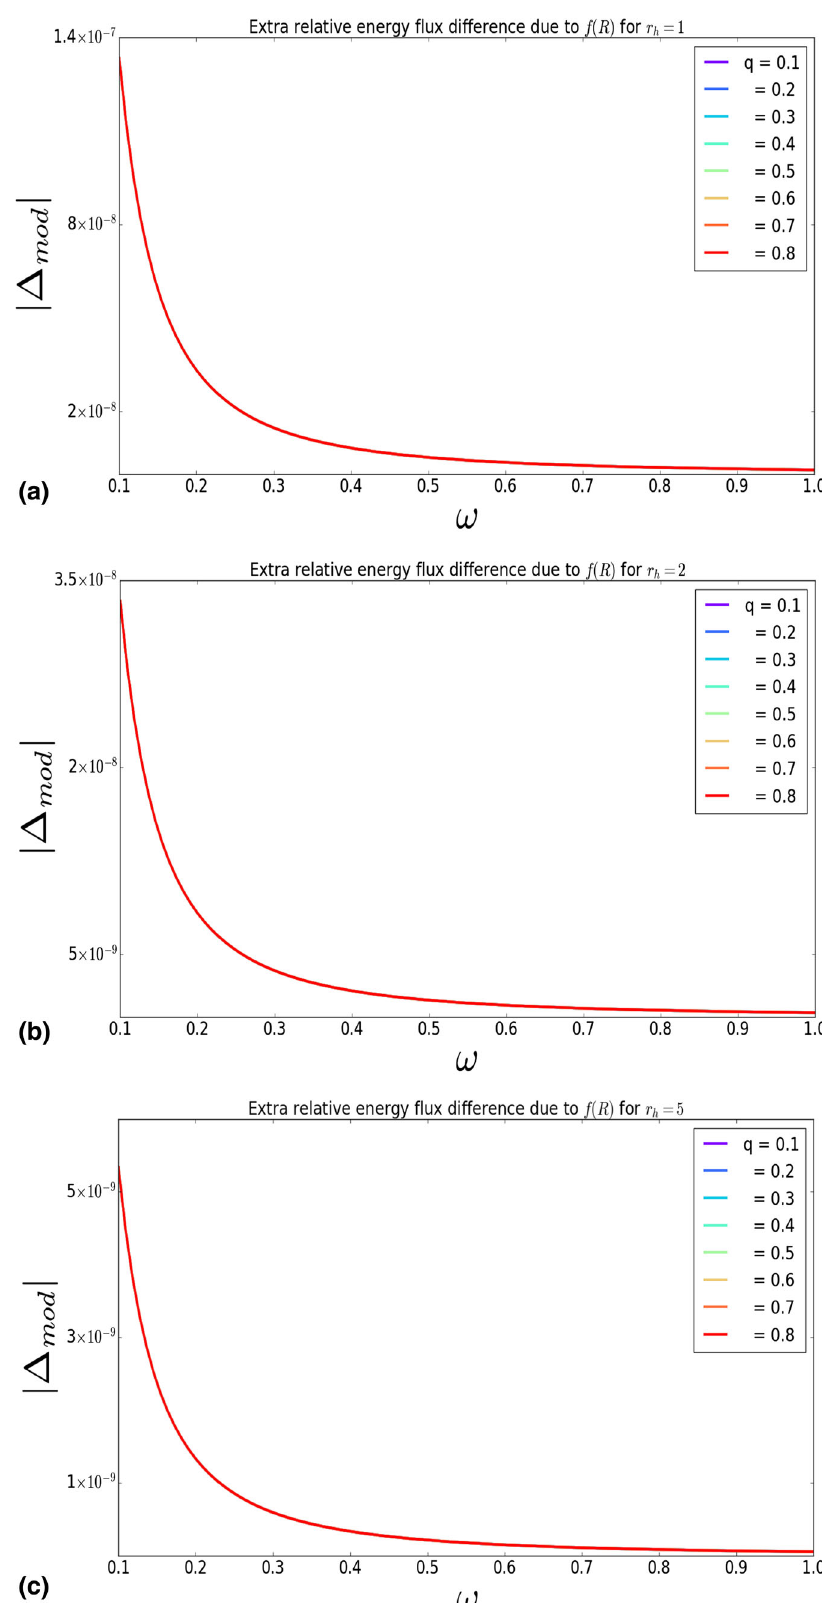
Fig. 3 Extra relative energy flux difference (cid:15) mod due to f ( R ) for three different horizon radii. Overlap of curves indicate weak dependence on